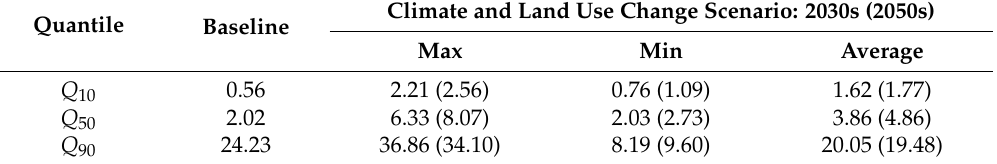
Table 5. Quantitative comparison (in %) of baseline scenario to mean, maximum, and minimum